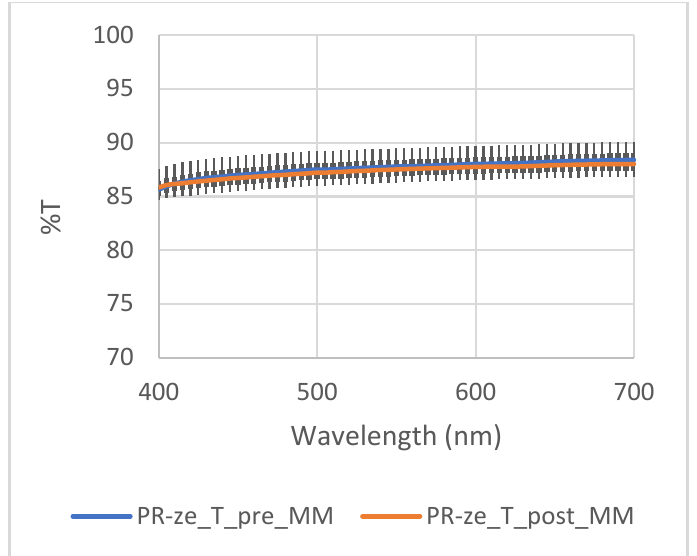
Figure 9. Transmittance values of the Zendura FLX with Prodways LD20 printer analyzed before and after aging. The curves are the average of nine spectrophotometry values ± SD. The percentage change, at two wavelengths of 400 nm and 700 nm is 0.2 and − 0.4, respectively, showing a transparency stability by the material and printer. This consistency of transparency is also found for the other two printers used, Carbon L1 and Rapidshape D100+, with the Zendura FLX material. (Figures 10 and 11) The transmittance data showed that before aging, the aligners produced with Scheu CA Pro + material had higher values than Zendura FLX, for all the 3D printers. Following treatment with artificial saliva and brown food coloring, the Scheu CA Pro+